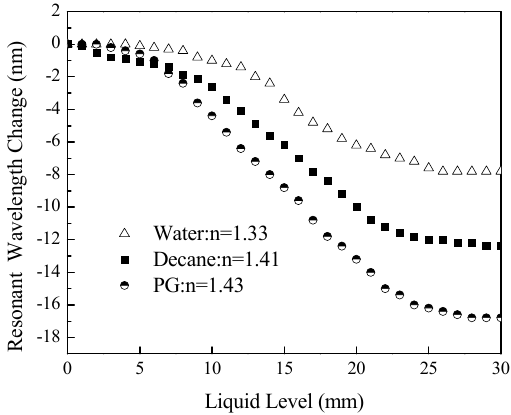
Figure 5. Resonant wavelength changes of LP 07 to the change of levels in water, decane, and propylene